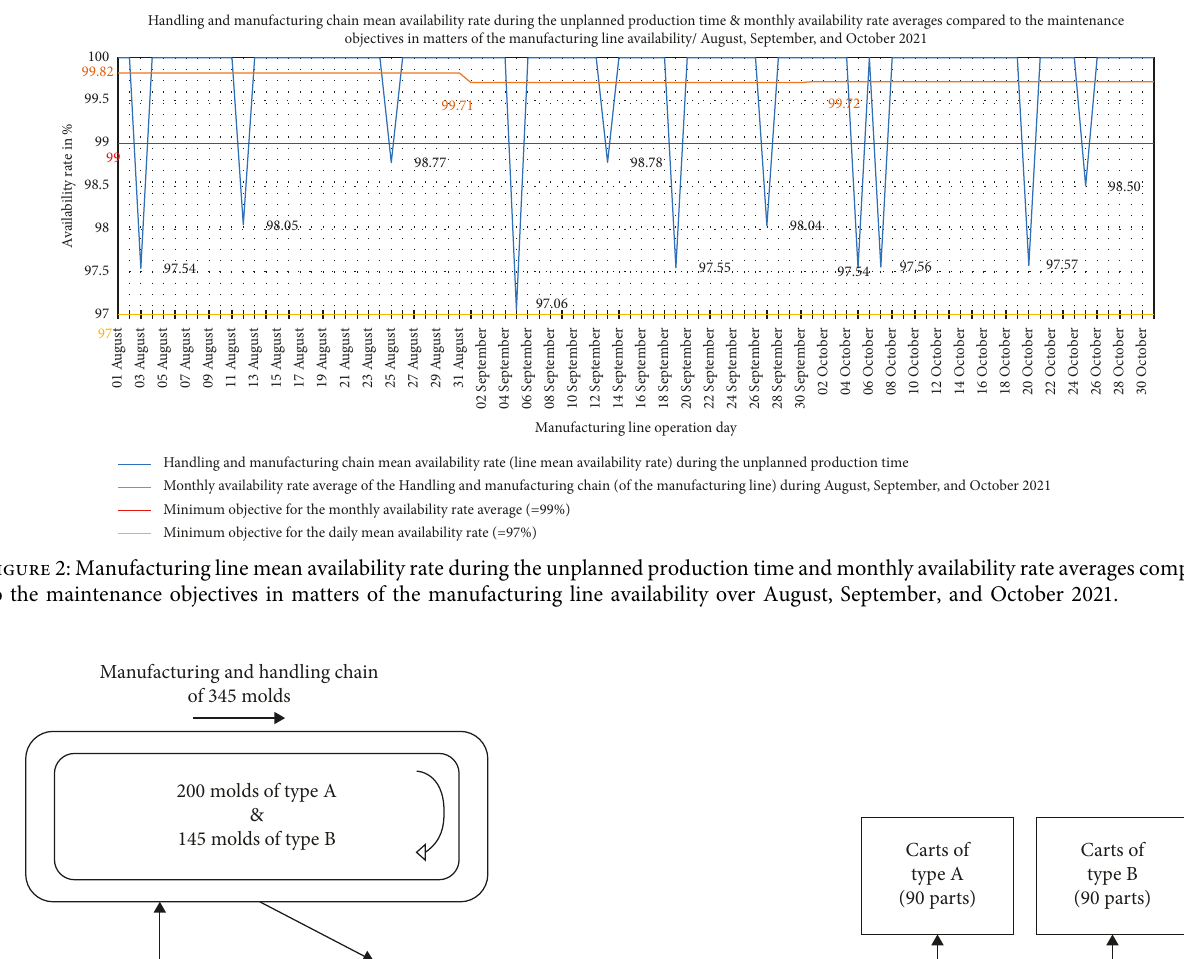
Loading of the chain molds by the liquid